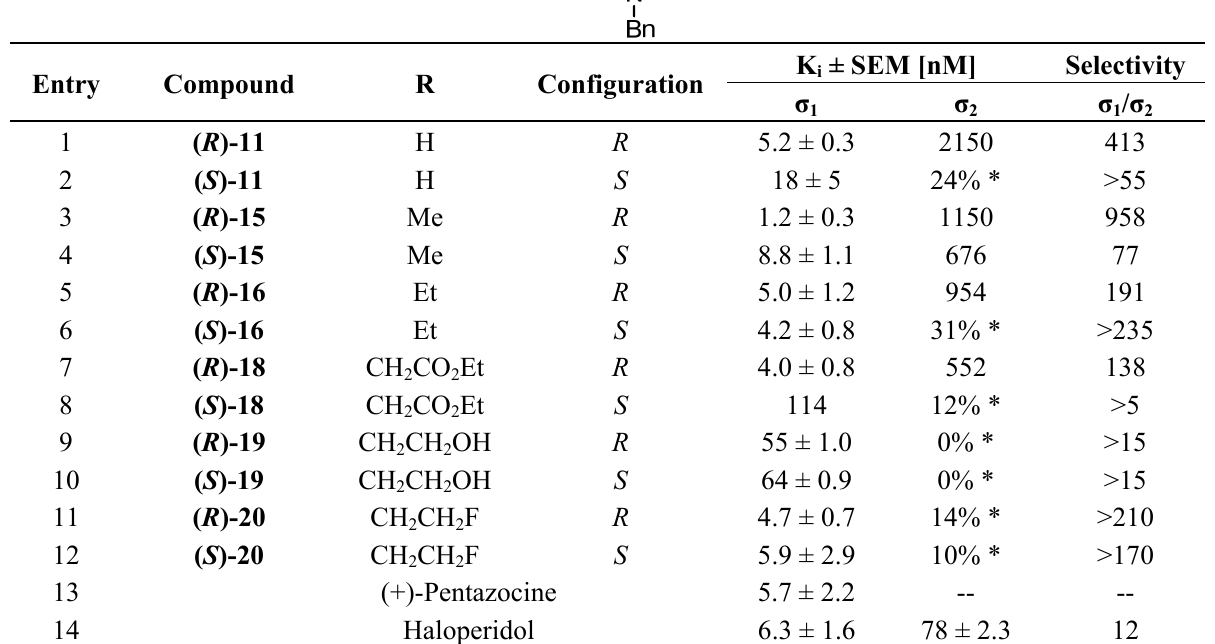
Table 1. σ and σ receptor affinities of ( R )- and ( S )-configured spirocyclic 1 2